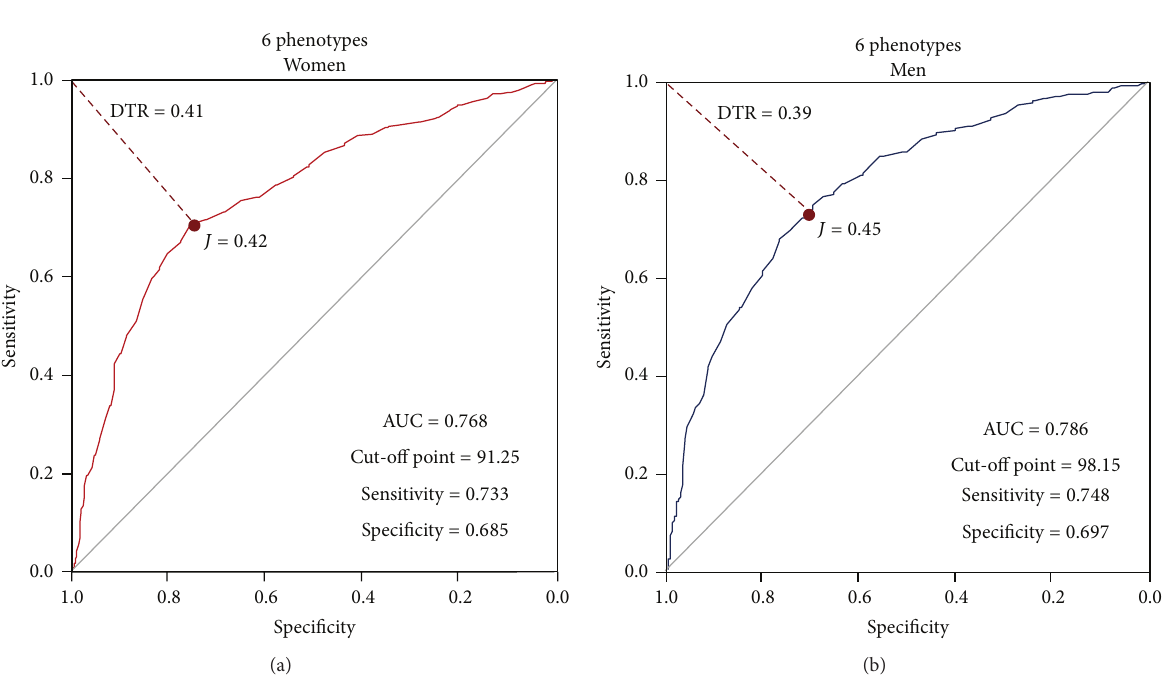
Figure 3: ROC curves constructed using 6